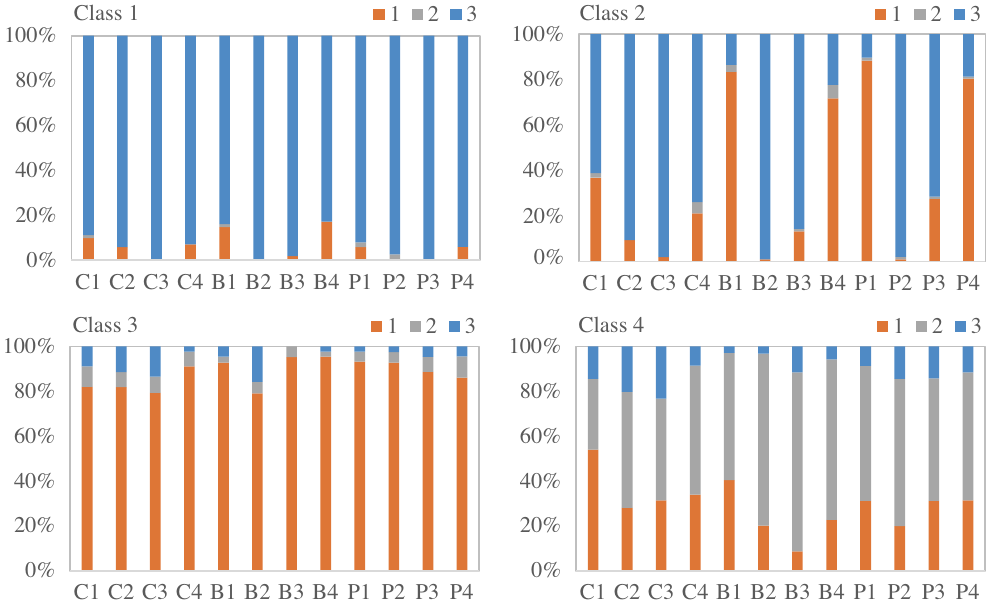
FIG. 4. The response patterns of the four classes obtained based on the four-class LCA model of the college dataset. C1-4, B1-4, and P1-4 represent the four questions in the three scenarios of collision, book, and pushing,